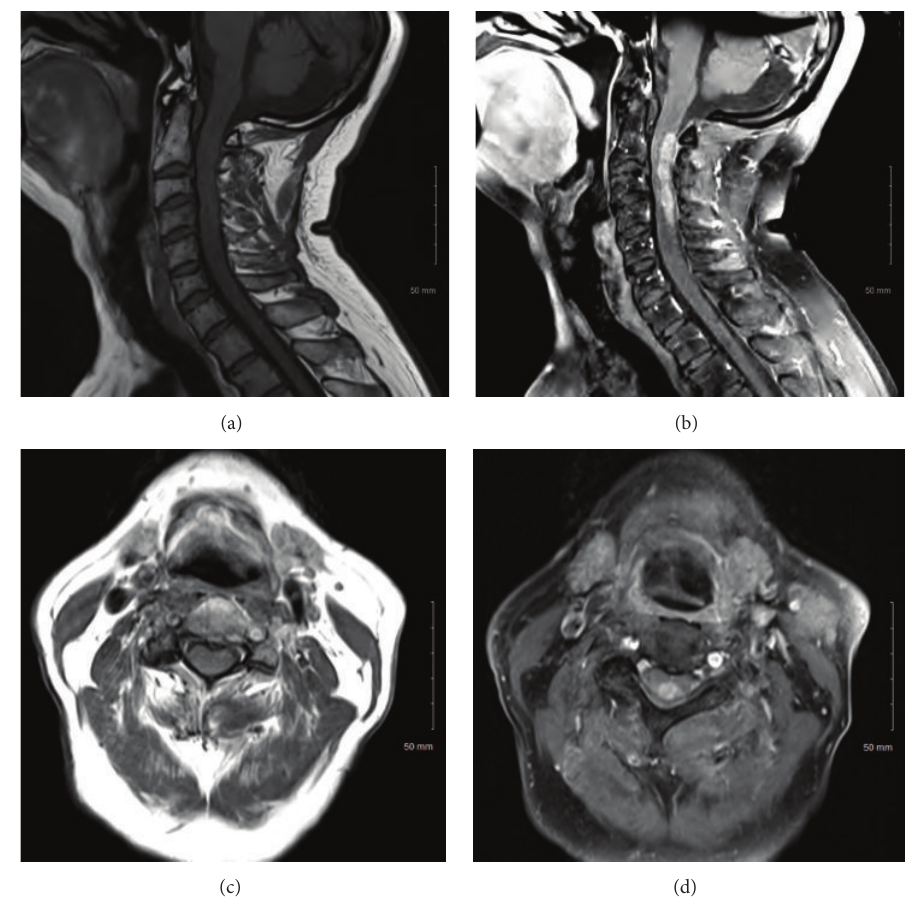
Figure 1: Preoperative T1-sequence MRI of the cervical spine. Sagittal images without (a) and with (b) gadolinium contrast material and axial images without (c) and with (d) gadolinium, showing an eccentric heterogeneously gadolinium-enhancing intramedullary mass between C2 and